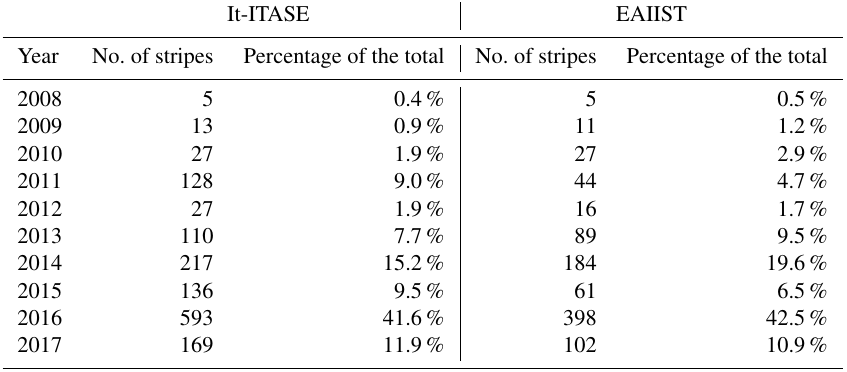
Table A2. Frequency of the REMA DEM stripes at the EAIIST and It-ITASE sites from different years, based on the REMA strip